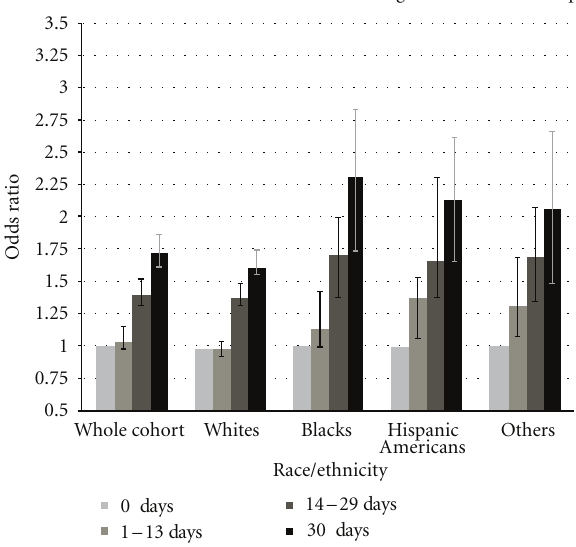
Figure 1: Association between insu ffi cient rest/sleep and coronary heart disease (CHD). X -axis: categories of insu ffi cient rest/sleep within the whole population and by di ff erent race-ethnicities. Y - axis: odds ratio of coronary heart disease prevalence (95% CI).